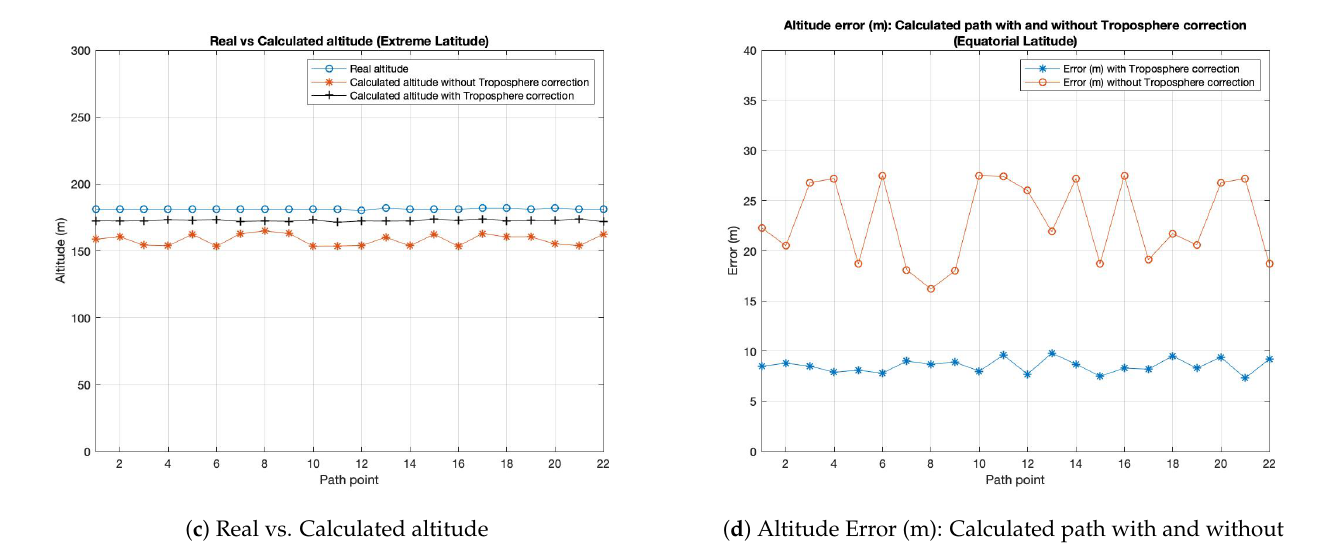
Figure 9. Experimental results for Equatorial Latitude (route in